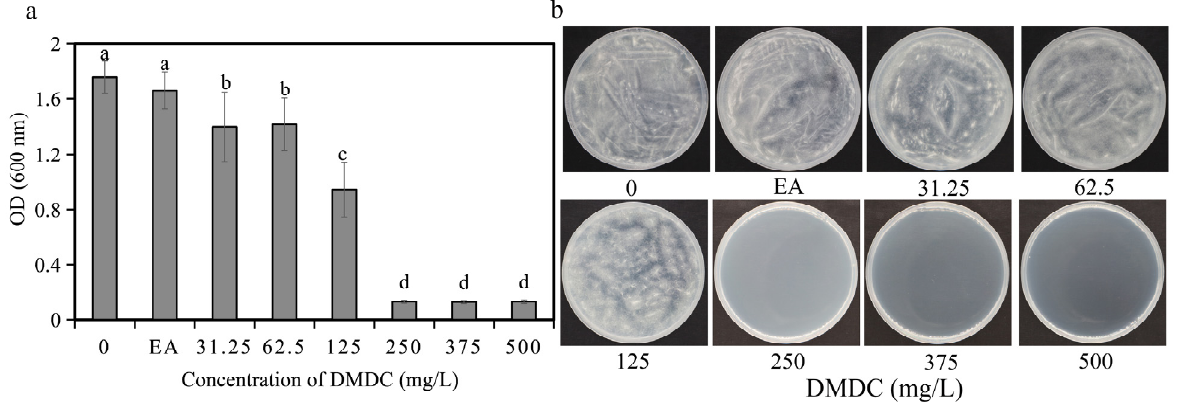
Figure 2. Effect of DMDC on fungal growth in vitro. ( a ) Dose–response curves of growth inhibition of G. citri-aurantii by DMDC in vitro. There were three replicates of the samples, and the data were the mean ± standard deviation of OD 600 measurements of G. citri-aurantii treated with DMDC after incubation for 4 days. Different letters on each column represent significant differences ( p < 0.05) according to Duncan’s test. ( b ) The growth of G. citri-aurantii on PDA plates after treatment with DMDC for 4 days.